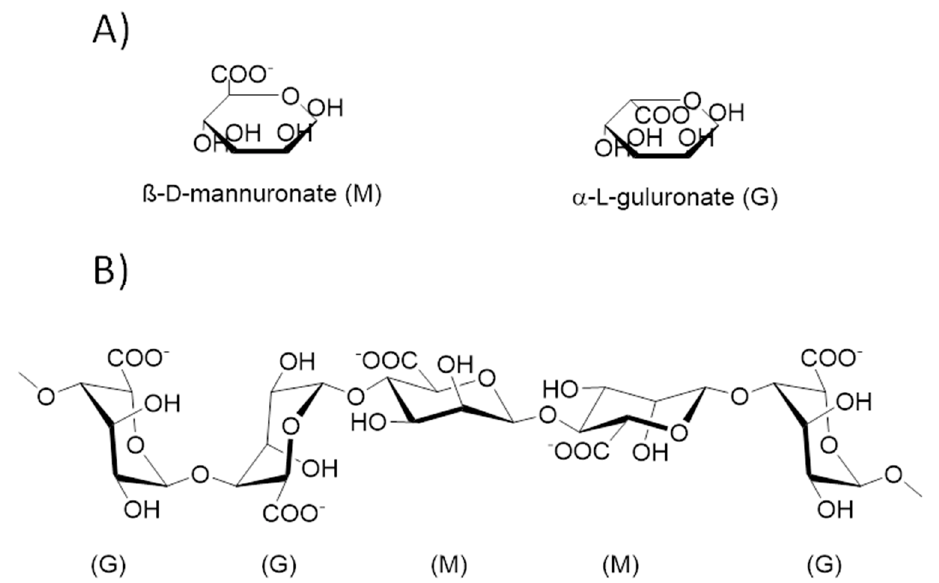
Figure 4. Alginate structure: ( A ) alginate monomer units; ( B ) alginate basic structure.